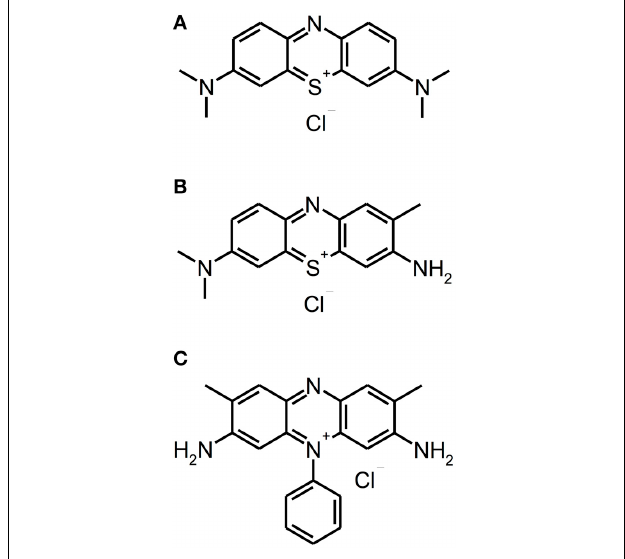
FIGURE 2 | Phenothiazinium derivatives. Chemical structures of phenothiazinium derivatives: (A) Methylene Blue. (B) Toluidine Blue. (C) Safranine